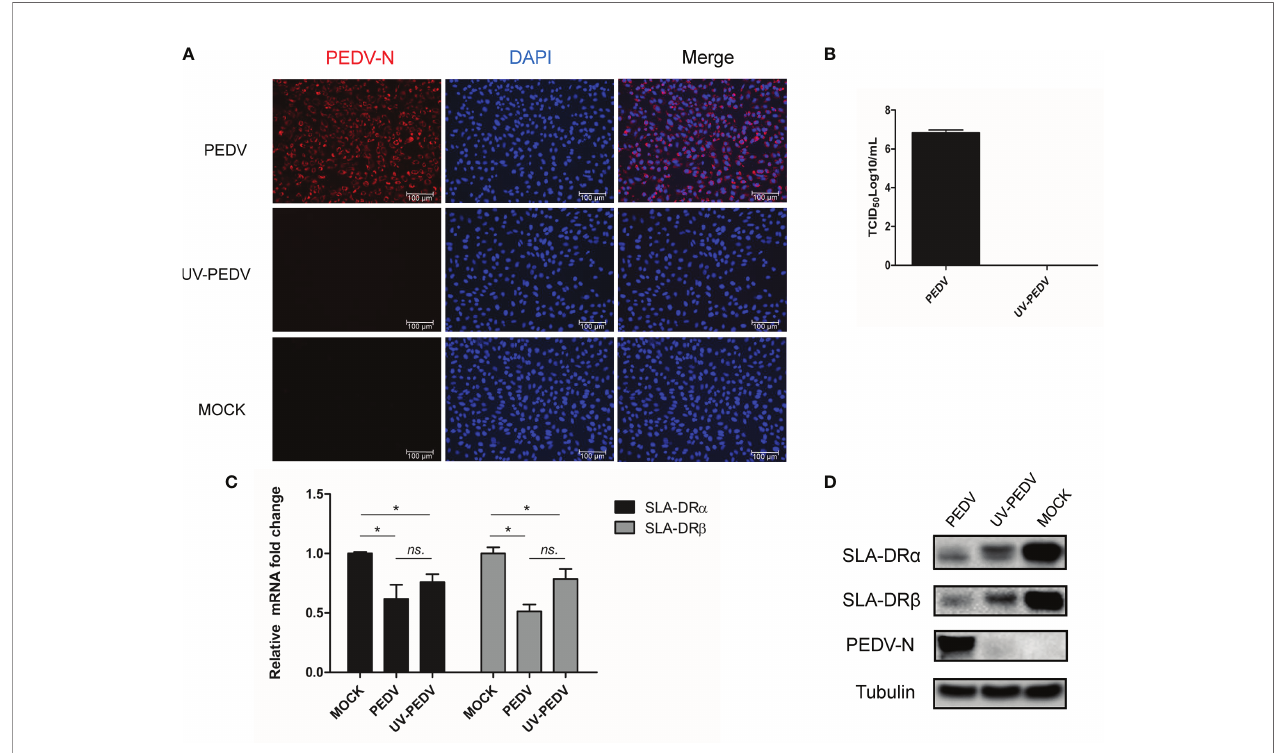
FIGURE 6 | Inhibition of SLA-DR expression in BM-DCs did not require PEDV replication. (A) BM-DCs were inoculated with either live PEDV-KB2013-p120 strain or UV-inactivated PEDV-KB2013-p120 strain for 24 hours. Next the cells were fi xed and stained with mice serum raised against recombinant PEDV-N protein and visualized by secondary antibody. (B) BM-DCs were inoculated with either live PEDV-KB2013-p120 strain (PEDV) or UV-inactivated PEDV-KB2013-p120 strain (UV- PEDV) for 24 hours. Next, cell culture supernatants were harvested and titrated in Vero cells. Error bars represent variation from at least three independent experiments. (C) BM-DCs were inoculated with either live PEDV-KB2013-p120 strain (PEDV) or UV-inactivated PEDV-KB2013-p120 strain (UV-PEDV) for 24 hours. Next, cells were harvested for qPCR evaluation of mRNA level of SLA-DR a and SLA-DR b . All experiment was repeated at least for three times. Signi fi cant differences between indicated groups was marked by * P < 0.05. (D) BM-DCs were inoculated with either live PEDV-KB2013-p120 strain (PEDV) or UV-inactivated PEDV-KB2013-p120 strain (UV-PEDV) for 48 hours. Next, cells were harvested for western blot using mice serum raised against recombinant PEDV-N protein, anti- SLA-DR a Mab and mice serum raised against recombinant SLA-DR b protein. Normal BM-DCs cells were included as control. Tubulin was probed from the same sample to normalize the total protein load. ns, non signi fi